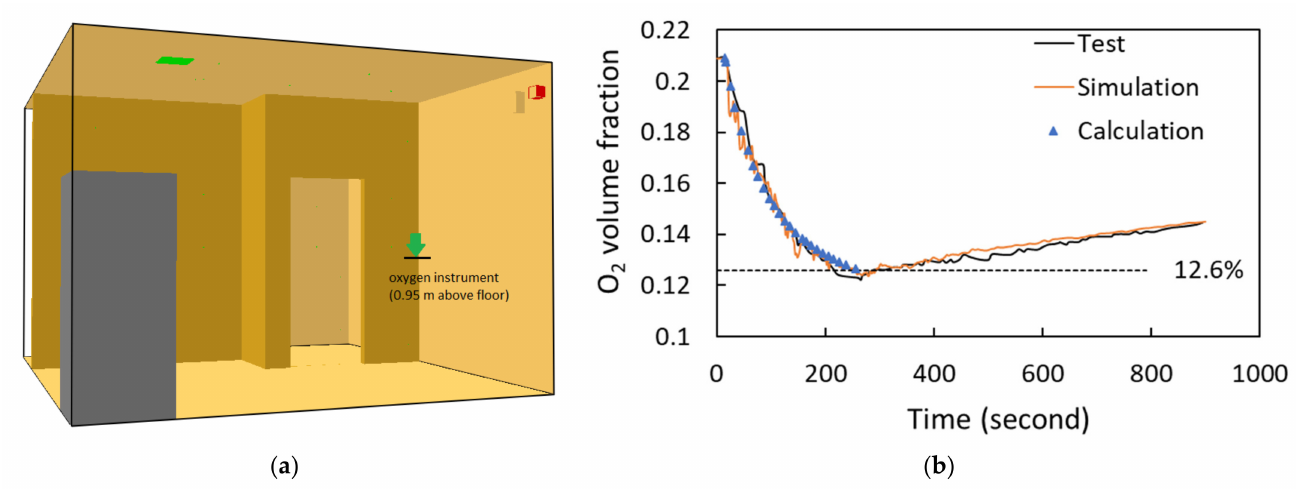
Figure 4. ( a ) The location of the oxygen instrument; ( b ) the oxygen volume fraction at this location. As the air-agent mixture was observed descending to the floor, the gas distribution along the height needs to be investigated. The oxygen fractions at 2.5 m, 0.95 m, and 0.25 m above the floor at the corner were predicted in the simulation case T1_bottom. Figure 5 shows that the oxygen fraction increases with the increasing height. The minimum oxygen fraction was 15.3% at 2.5 m above the floor, which was much higher than the design level. The oxygen fractions at the middle and lower layers, however, were very close to each other and reached the design level at the end of the discharge time. Therefore, it can be concluded that the oxygen fraction was distributed unevenly within the apartment. The oxygen fraction was much higher in the upper layer than that in the middle and lower layers. During the post-discharge time, the oxygen fraction increased 7% at 2.5 m